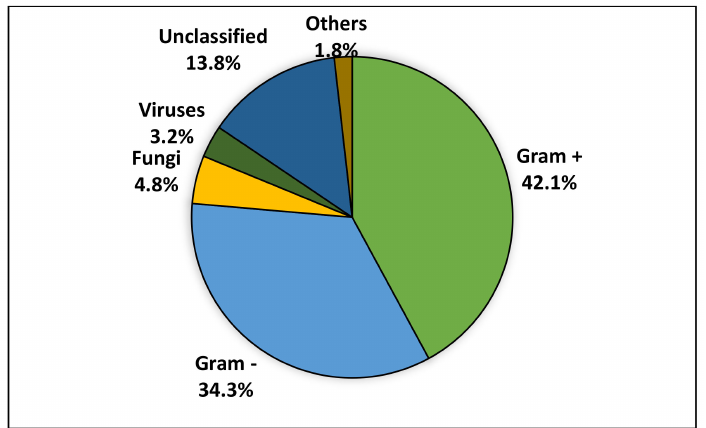
Figure 2. Pathogens involved in the microbiologically documented infections.